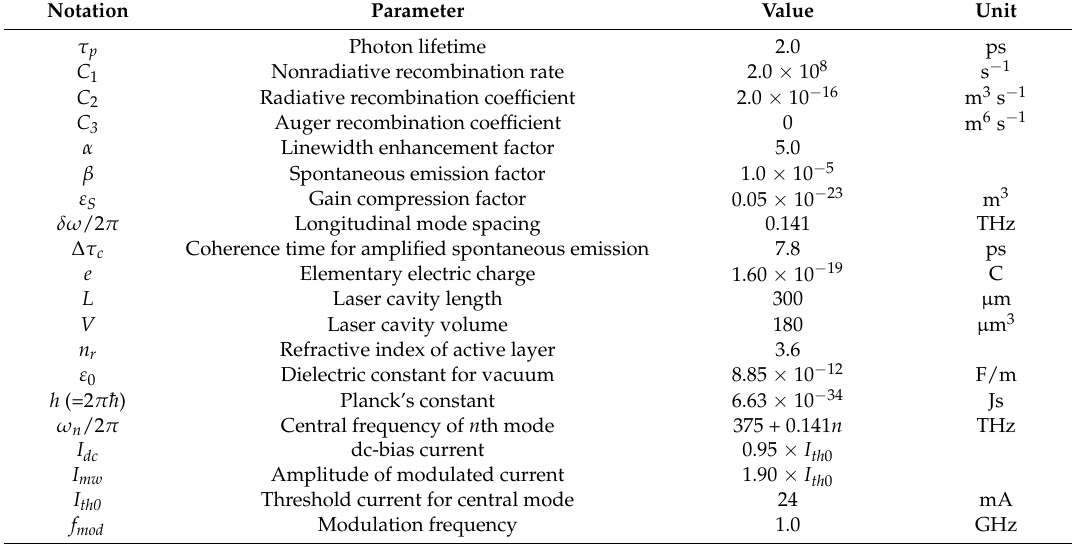
Table 2. Notation and values for parameters [22,23].